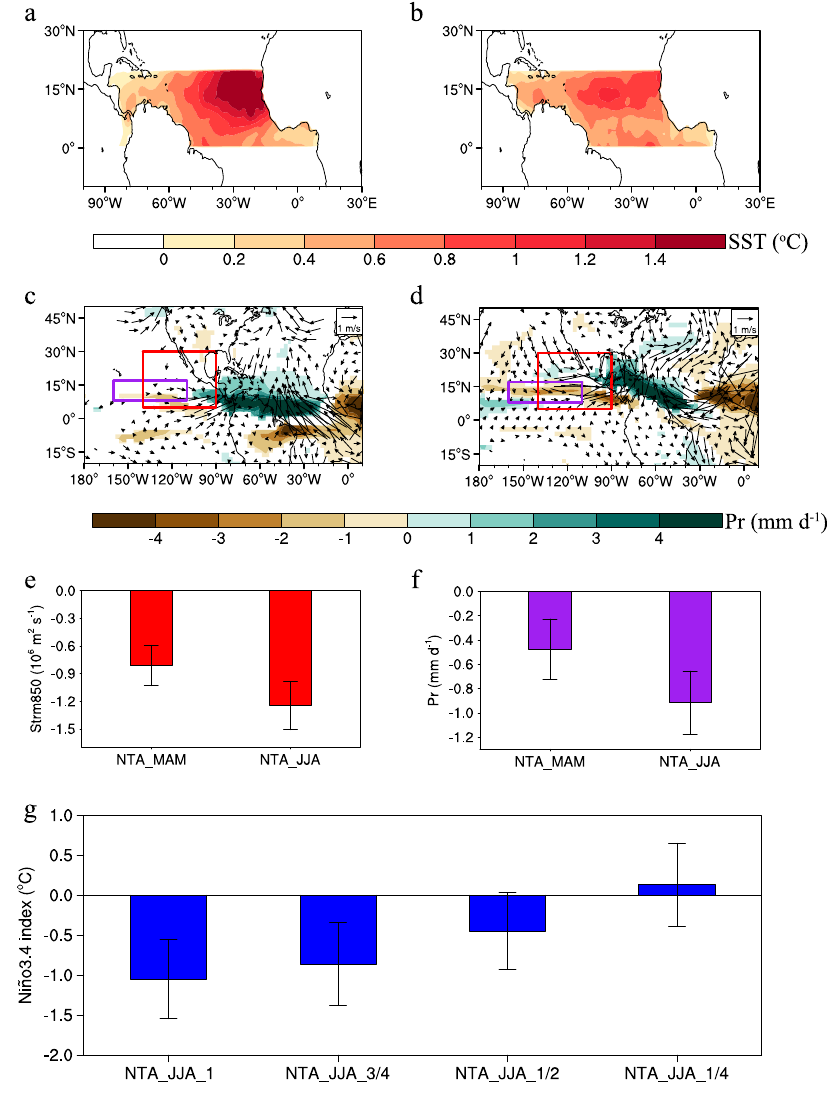
Fig. 4 | Simulated impacts of the North Tropical Atlantic (NTA) sea surface temperature (SST) persistence on the NTA − El Niño-Southern Oscillation (ENSO)connection.a , b Imposedspring( a )andsummer( b )NTASSTforcings(see Methods) in the atmospheric general circulation model (AGCM) experiments. c , d Responsesof850-hPawinds(vectors;ms − 1 )andprecipitation(shaded;mmd − 1 ) anomalies to the spring ( c ) and summer ( d ) NTA SST forcings in the AGCM experiments.Only850-hPawindsandprecipitationanomaliessigni fi cantatthe95% con fi dence level are shown. e 850-hPa stream function anomalies area-averaged over the region (5° – 30°N, 140° – 90°W) induced by spring and summer NTA SST